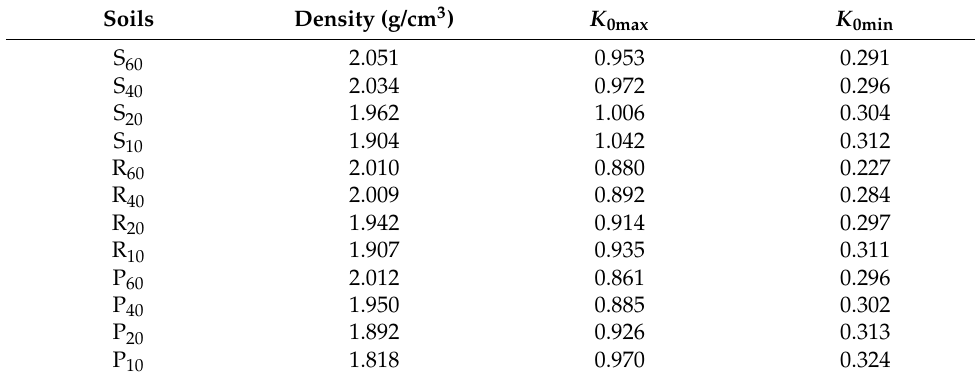
Table 4. Different dry densities, K 0max , and K 0min .